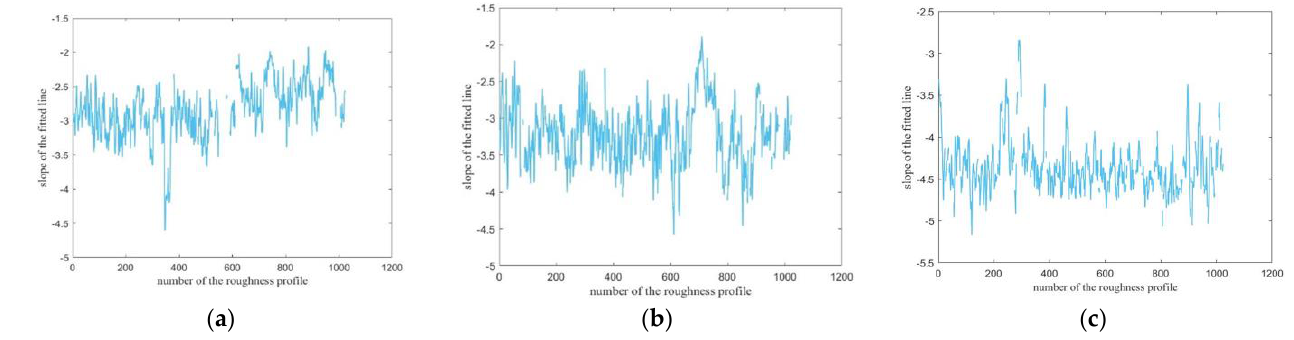
Figure 9. Results of 1024 slopes under each scale (9Cr18Mo). ( a ) 100 × ; ( b ) 50 × ; ( c ) 10 × .